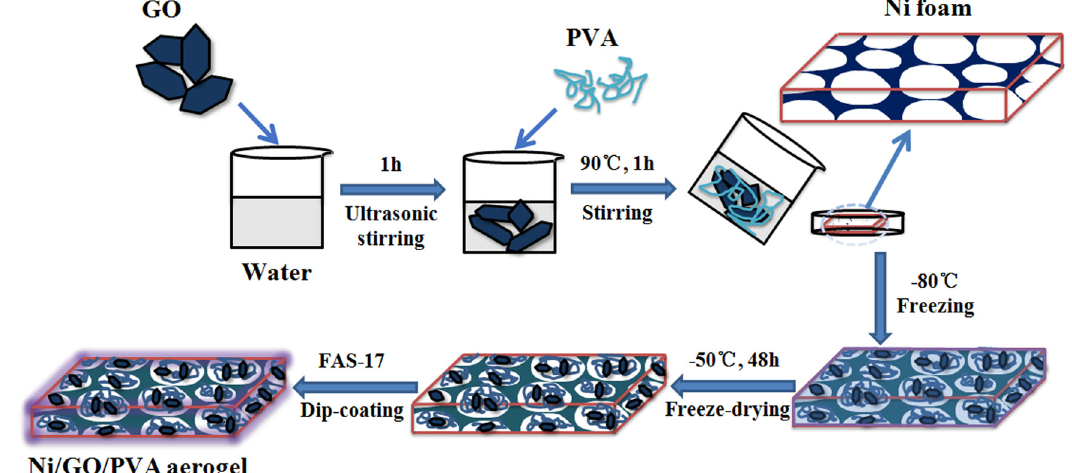
Figure 1: Preparation process of Ni/GO/PVA